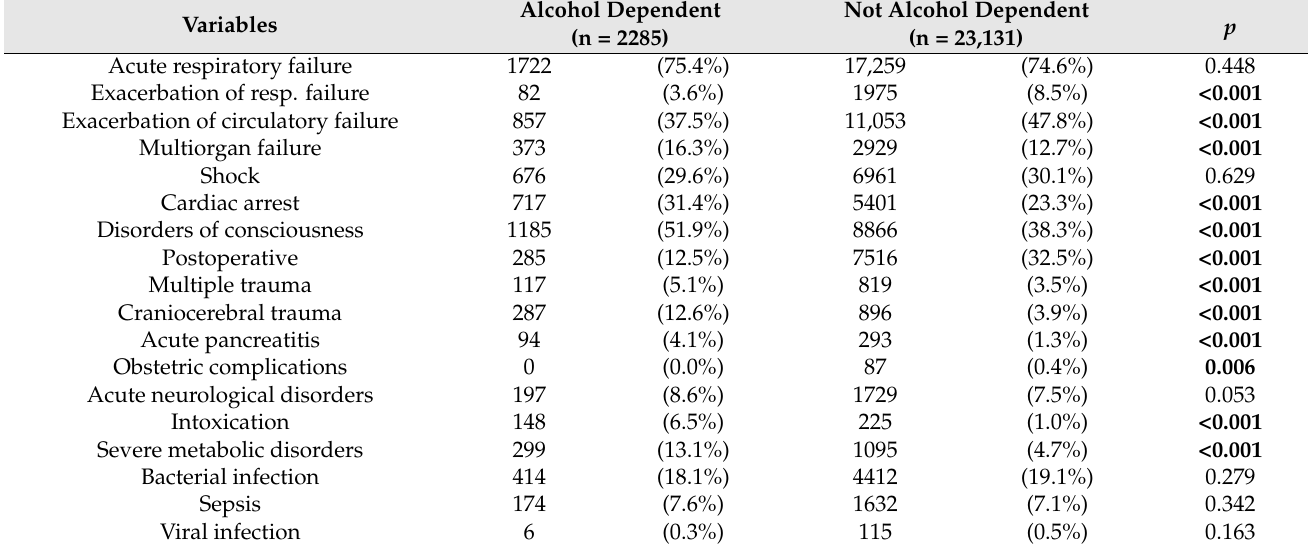
Table 2. Primary reason for ICU admission among patients with AD and the remaining population.